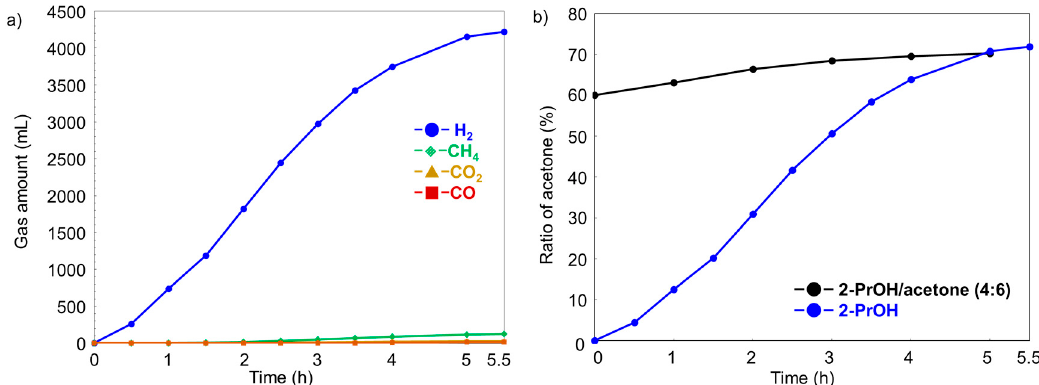
Figure 1. Time course study of the generation of various gases under dehydrogenation conditions of 2-PrOH under a circulation manner [methane (green line with rhombus dots), carbon dioxide (yellow line with trigonal dots), and carbon monoxide (red line with square dots)]. ( a ) Time-dependent production of each gas. The reaction was carried out under the conditions described in Scheme 2. ( b ) Time-dependent change of acetone / 2-PrOH ratio. The reaction was started with pure 2-PrOH (blue line) or acetone / 2-PrOH (6:4, black line). The hydrogen generation using acetone / 2-PrOH (6:4) was carried out under the conditions: 0.40 mL / min flow rate, 10-W microwave irradiation, and 2.0 MPa backpressure in circulation manner. Theoretical hydrogen evolution amount: 5.86 L.